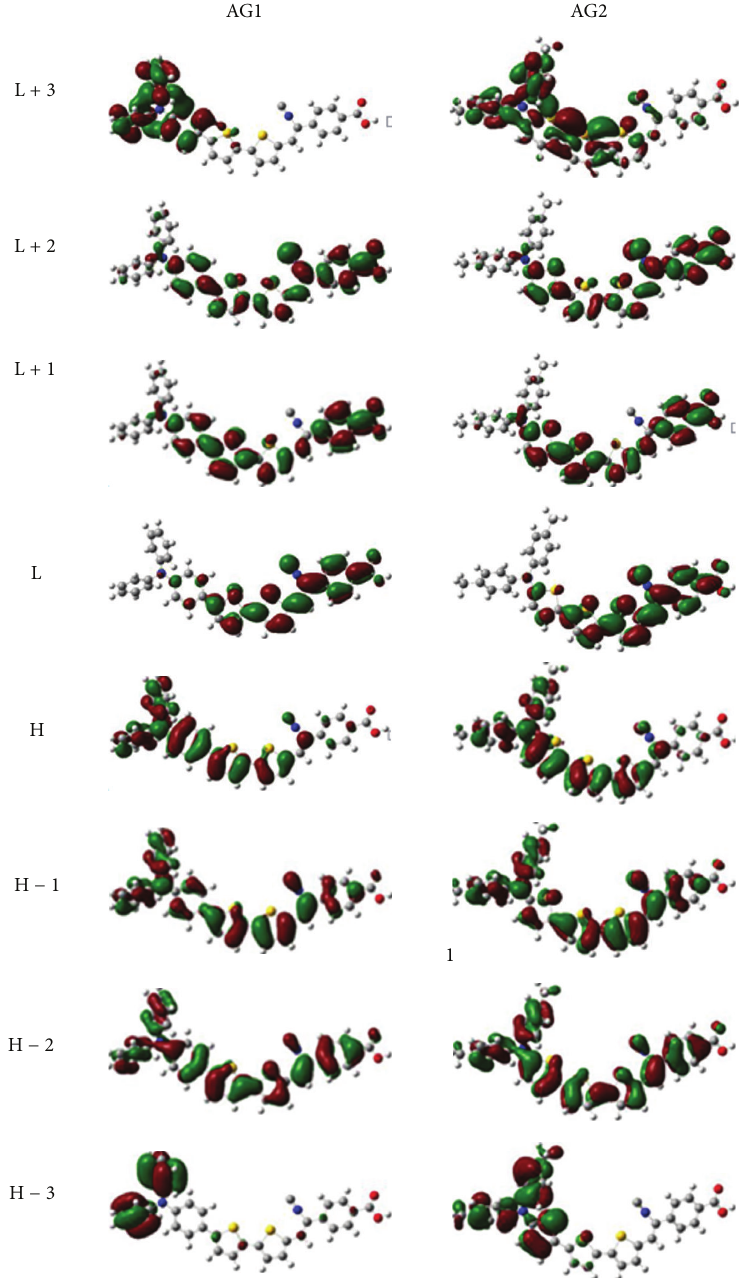
Figure 2: The plot surface of molecular orbitals of two compounds (AG1 and